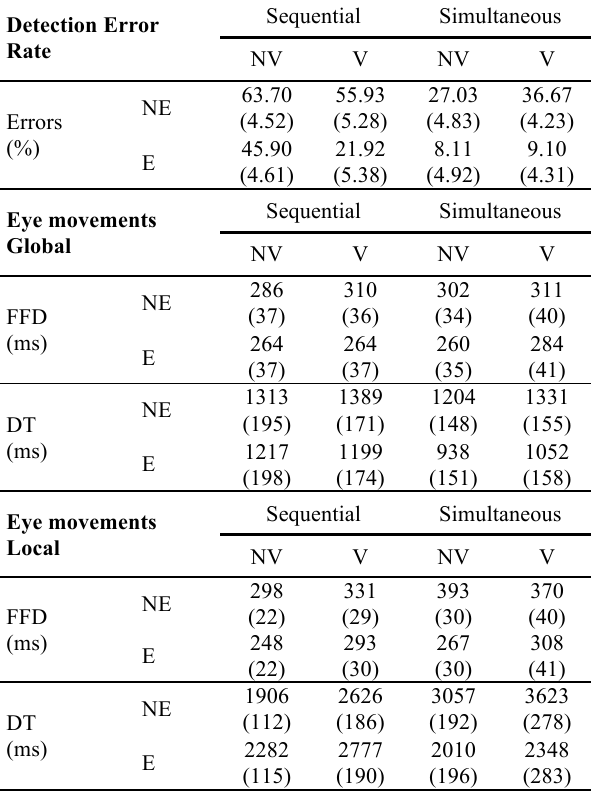
Table A. Results for detection error rate and eye movements (Gobal and Local